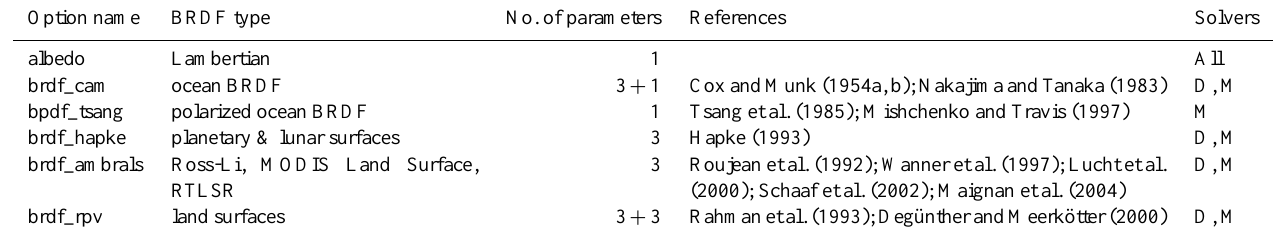
Table 6. The surface reflection models currently implemented in libRadtran.